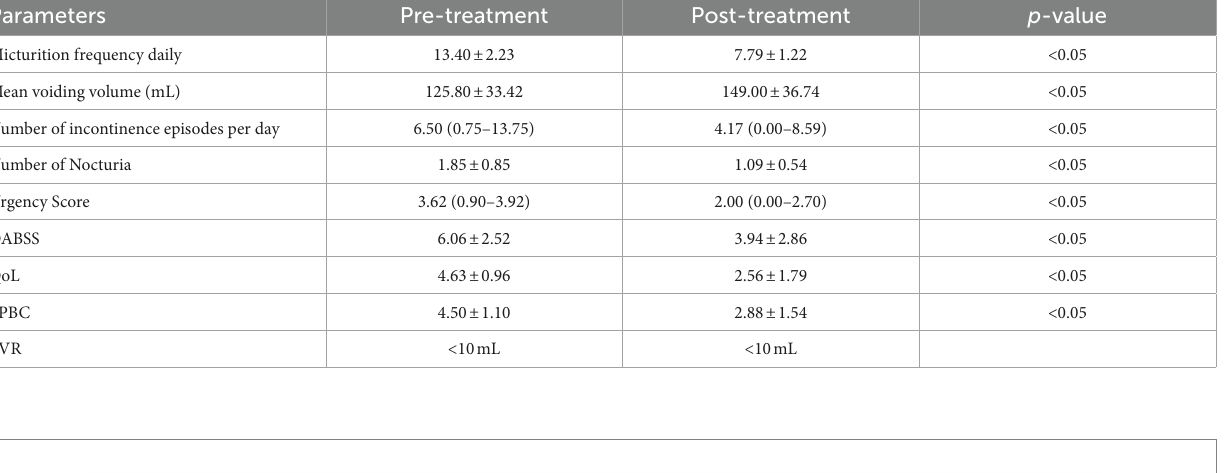
TABLE 3 Clinical parameters before and at completion of TNS